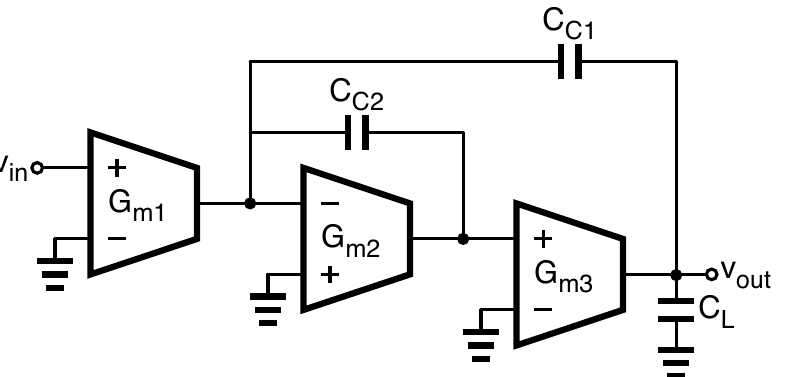
Figure 5. Block schematic of a three-stage amplifier. Capacitors C C1 and C C2 perform the Reversed Nested-Miller Compensation